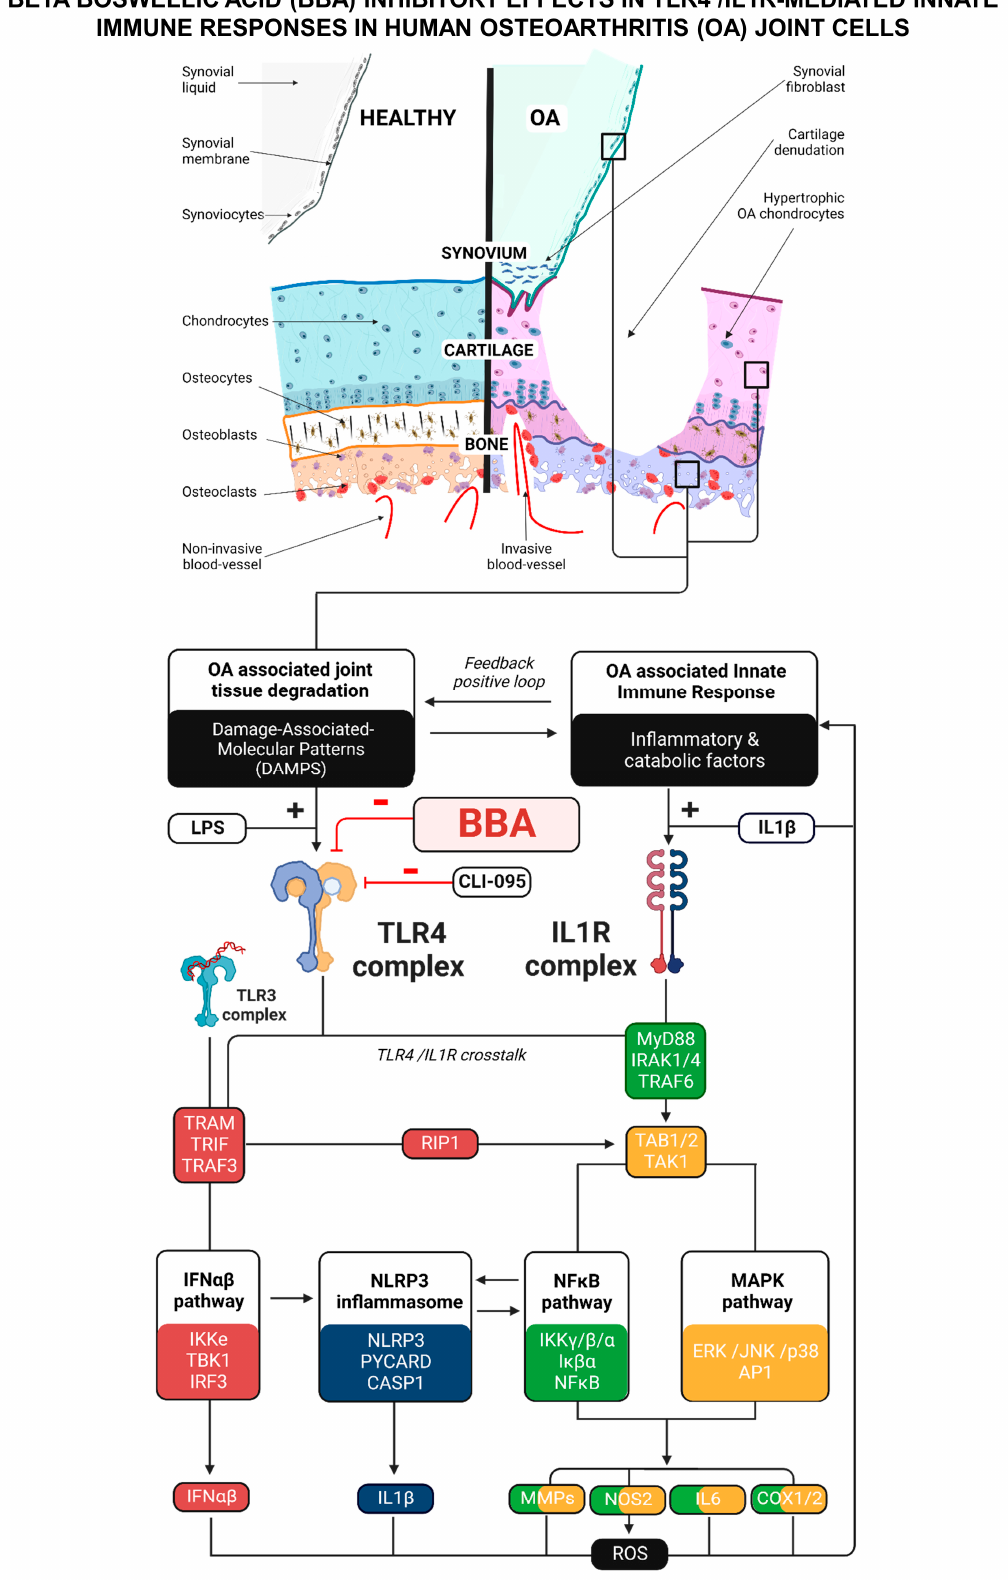
Figure 7. Diagram of TLR4/IL1R signaling, MAPK p38/NF κ B, IFN, TNF, and NLRP3 downstream pathways and innate immune response (IIR) in osteoarthritis (OA) joint cells.